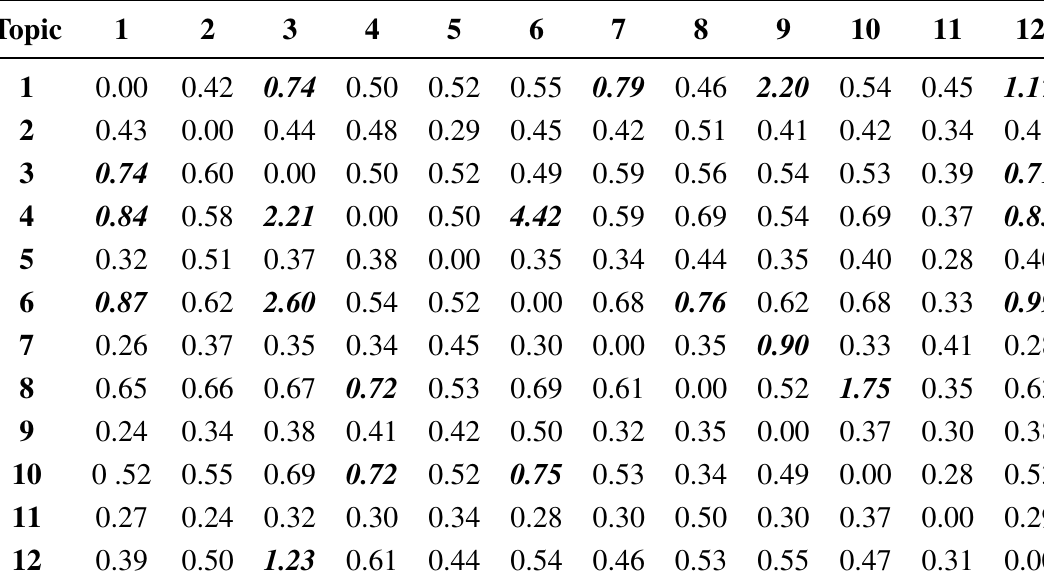
Table 2. Causal matrix for the roundabout dataset.